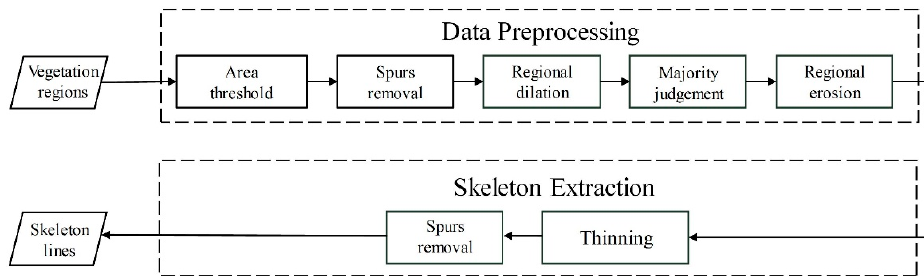
Figure 3. The flowchart of skeleton extraction.